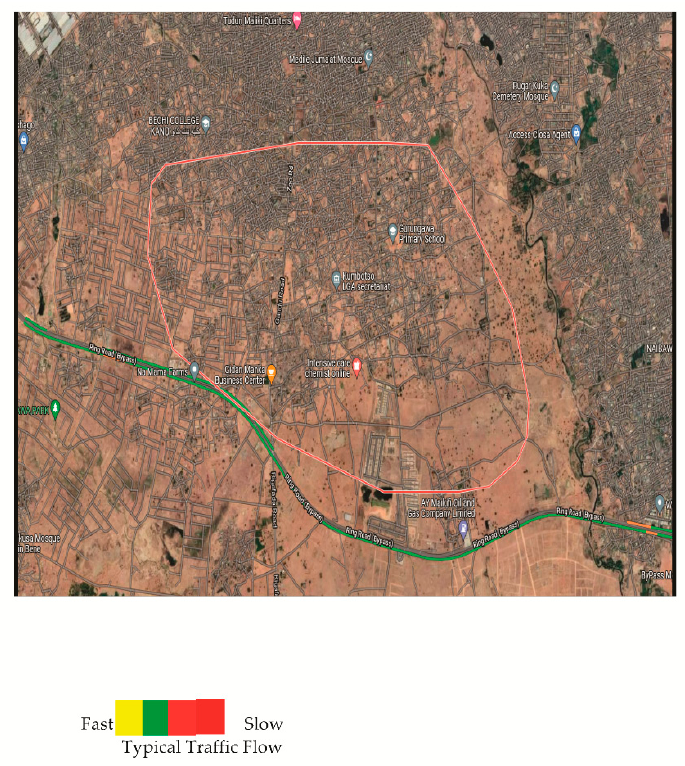
Figure A2. Map of Nigeria highlighting Kano State and satellite image of Kumbotso Local Government Areas showing typical week day traffic (Source: Google maps ® ).